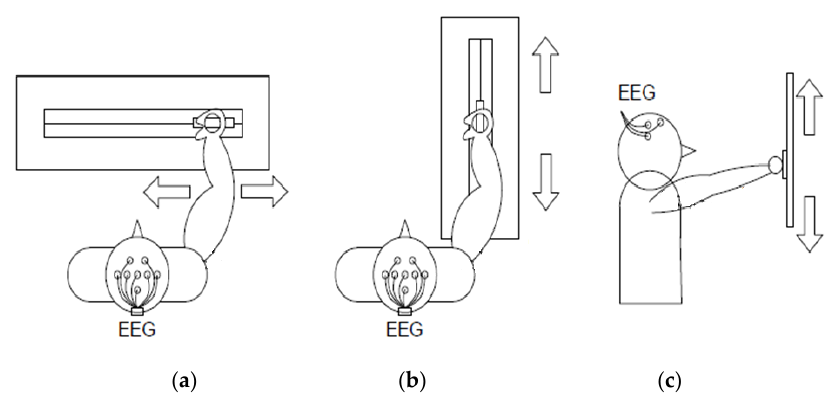
Figure 1. Rehabilitation guide operation modes. EEG = electroencephalogram. ( a ) Transversal movement; ( b ) longitudinal movement; ( c ) vertical movement.